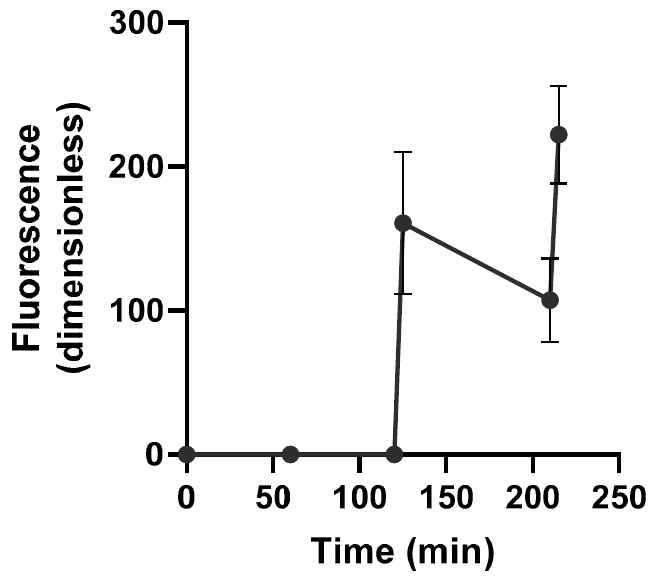
Figure 6. The time-dependent fluorescent intensity of supernatant from immersed fibrin hydrogels exposed to two 5 min heating cycles at t = 120 and 210 min. The supernatant was returned to the immersion solution following measurement and allowed to cool to room temperature prior to a second heating cycle (n = 3).